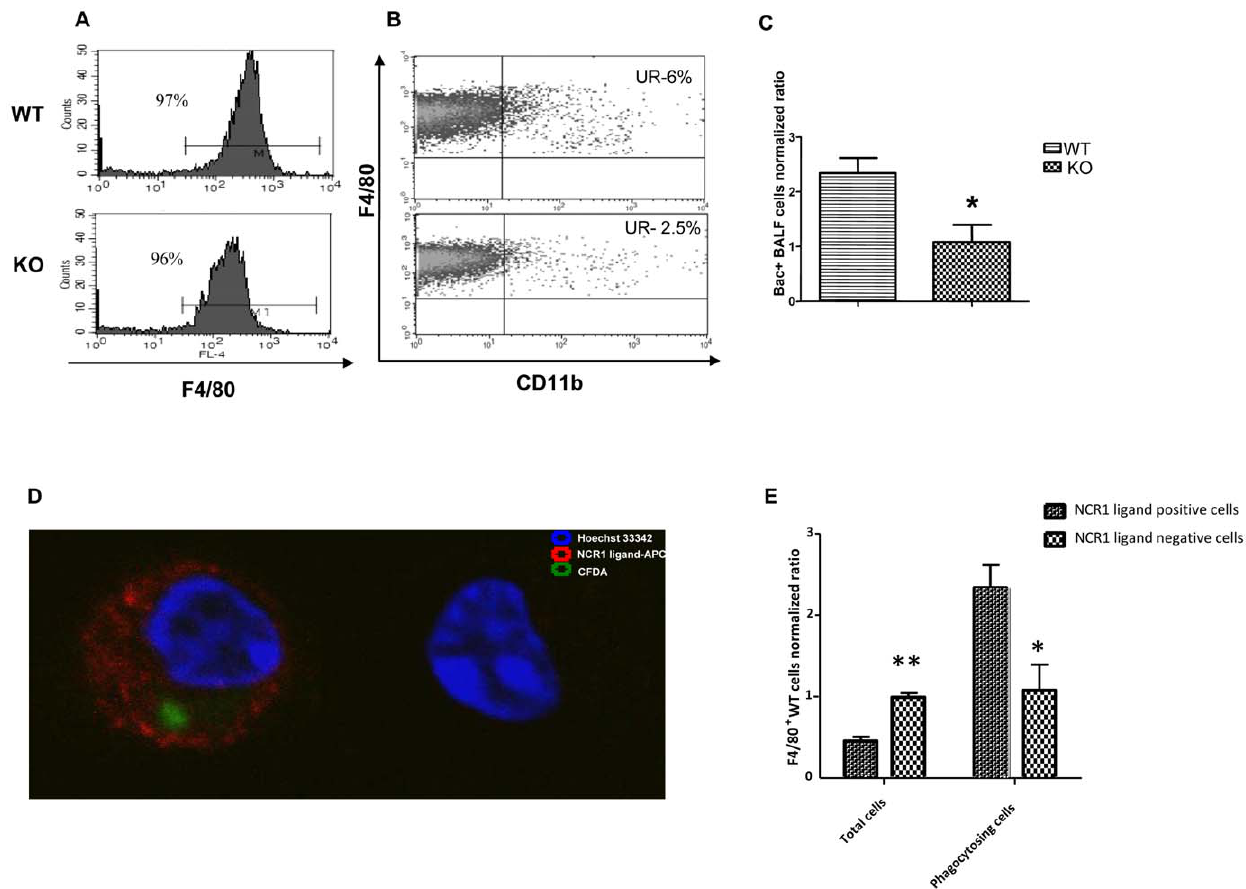
Figure 8. NCR1 contribution to activation of naı¨ve alveolar macrophages . BALF cells were harvested from Ncr1 + / + and Ncr1 gfp/gfp naı¨ve C57BL/6 lungs. Alveolar macrophages were gated by staining with mAbs to CD45 and F4/80 (A) and gated cells were analyzed for the expression of CD11b (B) by flow cytometry. Numbers indicate percentage of alveolar macrophages in BALF (A) and fraction of CD11b positive alveolar macrophages (B). Results are from one representative experiment of five. (C) BALF cells taken from NCR1 + / + (WT) and NCR1 gfp/gfp (KO) mice were incubated with 1 MOI CFDA-labeled S. pneumonia for 2 h. Cells were then washed and visualized with a fluorescent microscope. The bar graph (C) shows the average of fluorescent BALF cells (bac positive) from 11 microscopic fields. Numbers were normalized to the average of fluorescent BALF cells from NCR1 gfp/gfp mice, which was considered as 1. *p , 0.05 compared to NCR1 + / + group, + SD (ANOVA test). Results are from one representative experiment out of two. (D–E) Ncr1 + / + BALF were incubated with 1 MOI CFDA-labeled S. pneumonia for 1 hr. Following wash of bacteria, cells